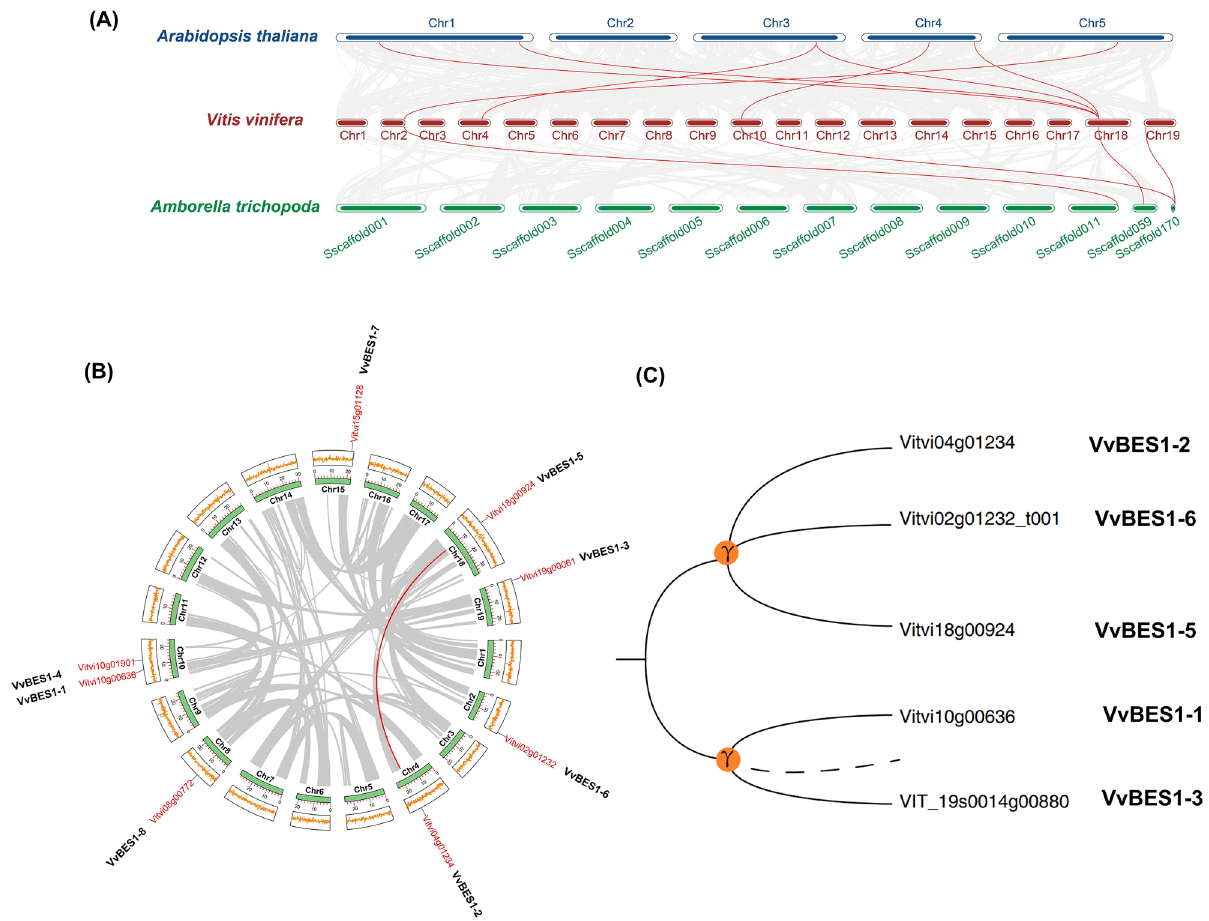
Figure 5. Collinearity analysis of BES1 genes and evolutional analysis of VvBES1 gene family. ( A ) Interspecific syntenic relationships of BES1 gene family among A. thaliana , A. trichopoda and V. vinifera genomes, the red line represents BES1 gene pairs with collinear relationship between V. vinifera vs. A. trichopoda as well as V. vinifera vs. A. thaliana . The serial number is expressed on each chromosome. ( B ) Intraspecies syntenic relationships of VvBES1 gene family in V. vinifera genome; the gray line represents the gene pairs with collinearity in the whole V. vinifera gene family, and the red line represents the gene pairs with collinearity in the VvBES1 family. Chromosome length (Mb) is indicated by the scale bar on each chromosome, and the yellow boxes upon the chromosomes indicated corresponding GC content of each chromosome. ( C ) Retention and loss of copies in VvBES1 gene family after species evolution. The solid line represents the BES1 gene with three copies, and the dotted line represents the BES1 gene with one copy